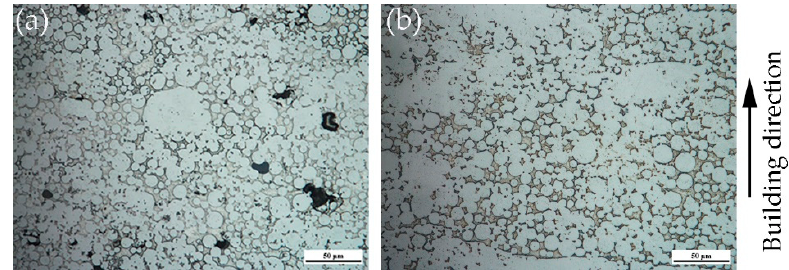
Figure 17. Vertical morphology of the 90W ‐ 7Ni ‐ 3Fe under different VEDs. ( a ) 253.97 J/mm 3 ; ( b ) 518.52 J/mm 3 .